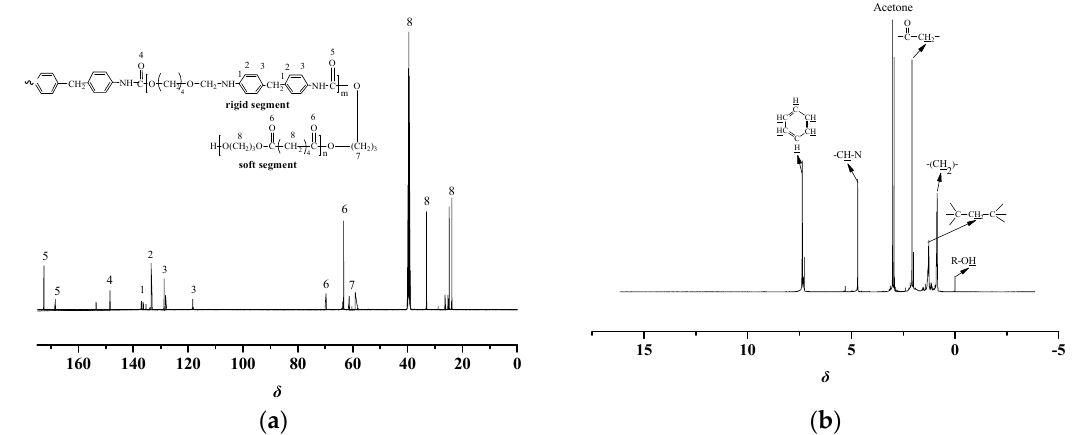
Figure 10. 13 C and 1 H NMR spectra of polyester-based TPUs. ( a ) 13 C NMR spectra; ( b ) 1 H NMR spectra. Materials 2020 , 13 , 4991